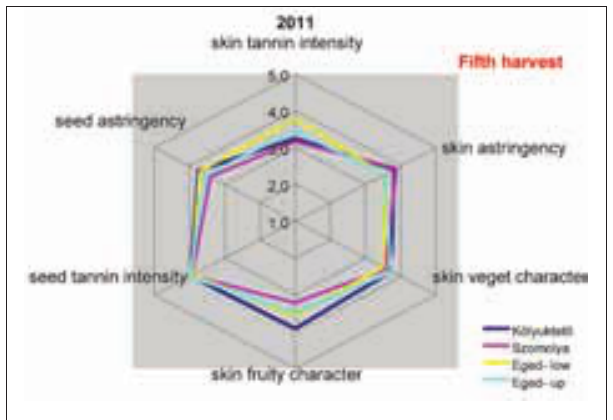
Figure 1e: Main sensorial characters of the berry skin and the seeds (2011- Fifth harvest time)